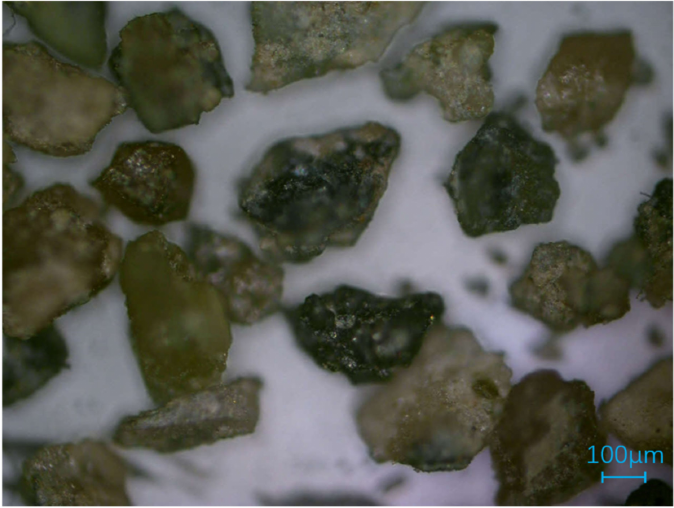
Figure 12. Apparent color of mineral dust (the length of the ruler in the figure is 100 µ m).